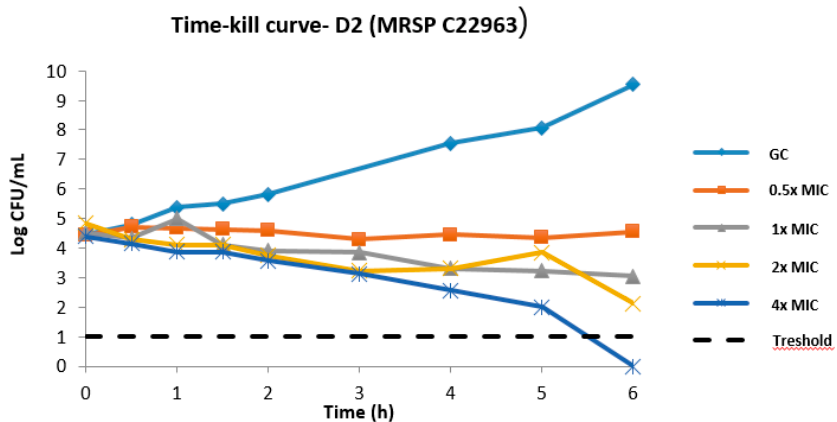
Figure 2. Time–kill curve of D2 against a clinical MRSP isolate (C22963). GC: Growth control. We observed regrowth after 24 h (data not shown).